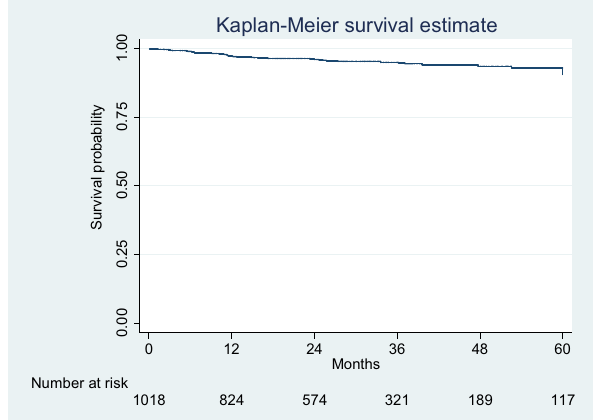
Figure 1. Kaplan–Meier survival curve for time to recurrence for all 1018 patients. Overall recurrence-free survival was 97%, 95% and 88% at 12 months, 36 months and 60 months, respectively.